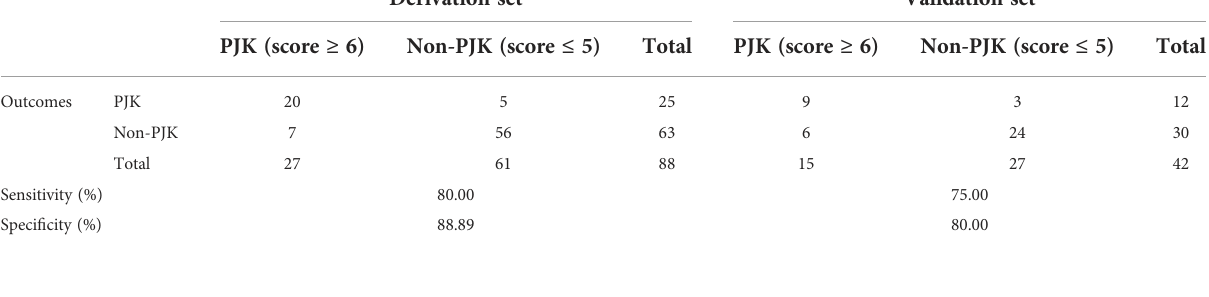
TABLE 4 Comparison of performance of the scoring system on derivation set and validation